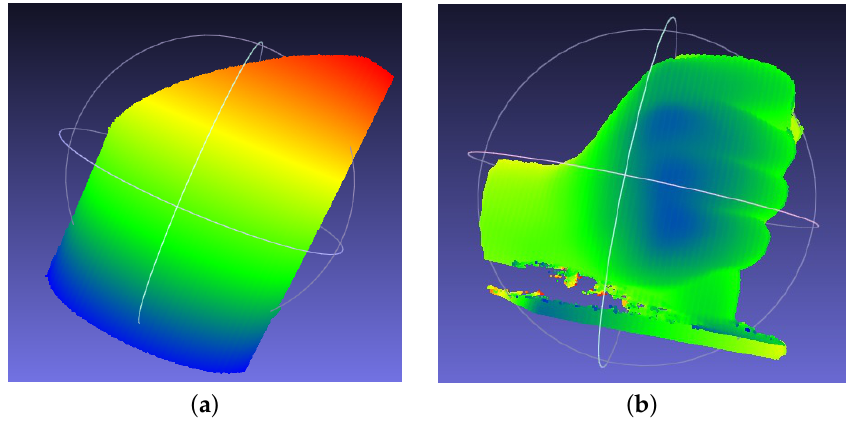
Figure 9. 3D measurement by the fringe projection vision system. ( a ) Cylinder and ( b ) hand surfaces displayed with the Meshlab